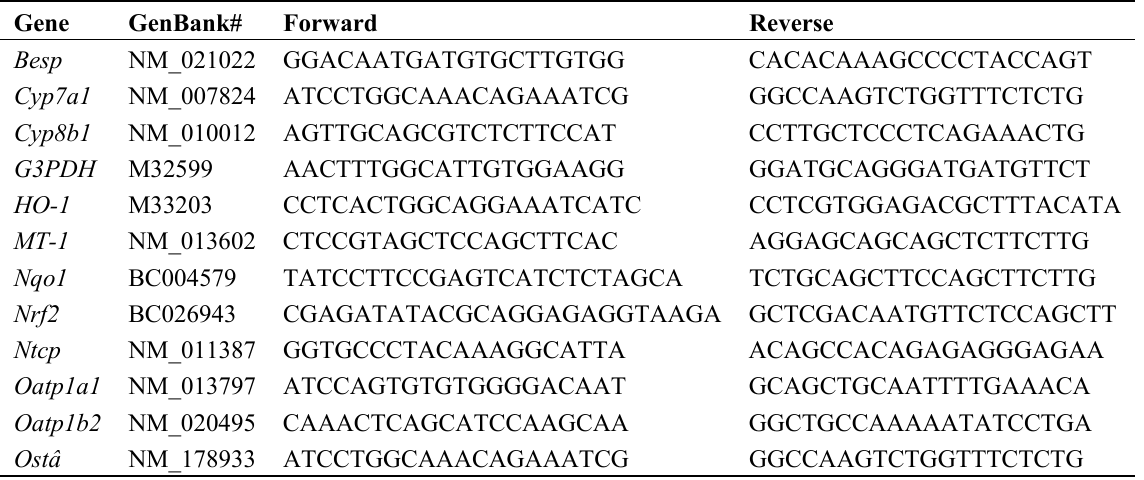
Table 1. Real-time RT PCR primer